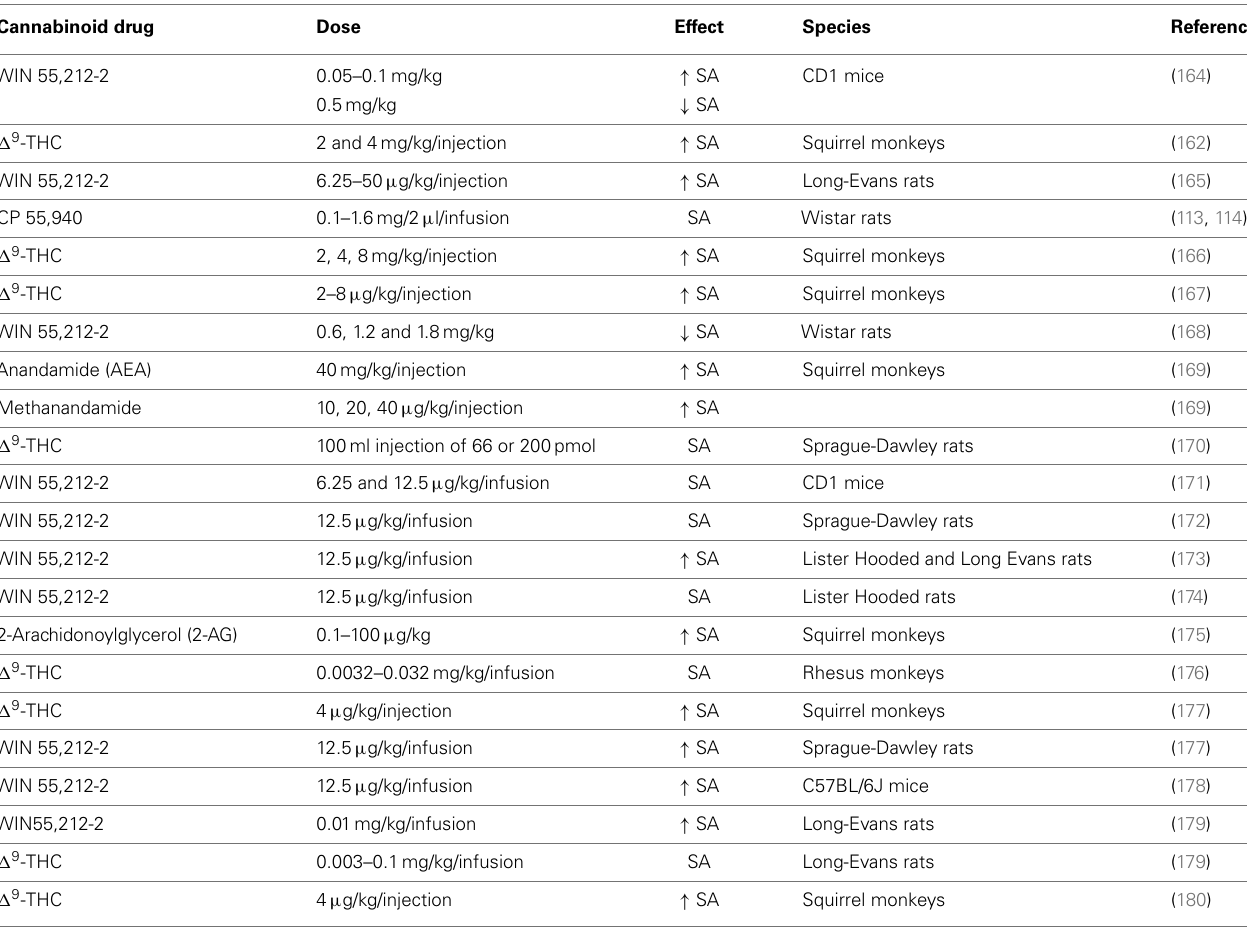
Table 3 | Cannabinoid effects on self-administration in experimental animals . Cannabinoid